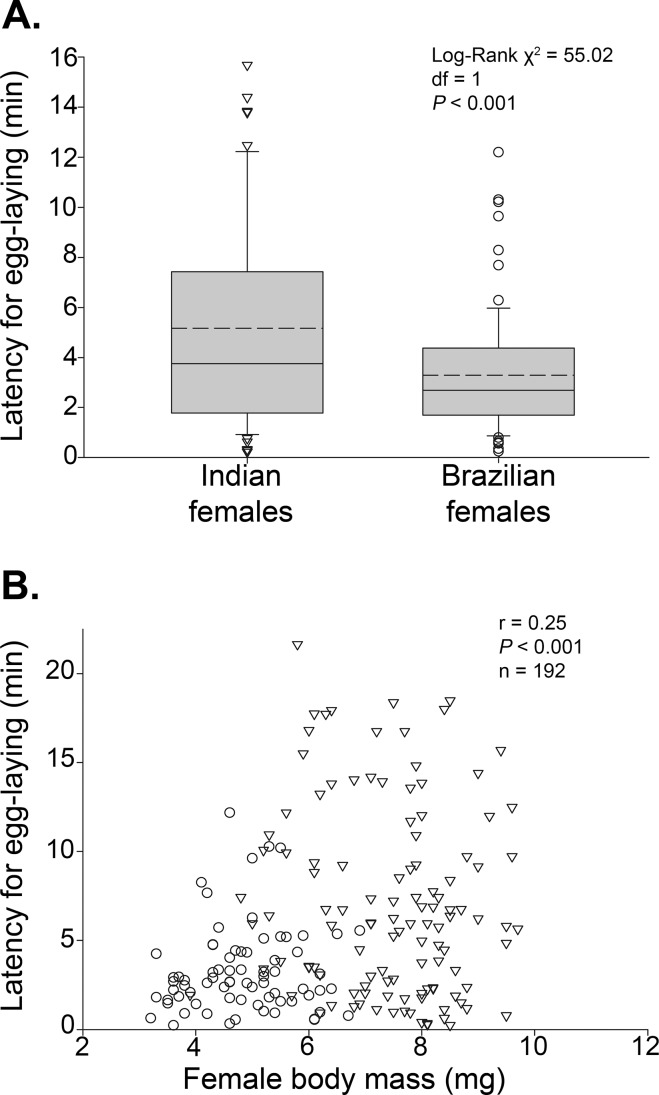
Latency to lay eggs on seeds in adult female cowpea beetles Callosobruchus maculatus during dichotomous choice trials.(A) A comparison of egg-laying latencies between Indian and Brazilian strain females showing that Indian females take longer to lay; the box plots indicate the median (solid line), mean (dashed line), and range of dispersion (lower and upper quartiles, and outliers) of the latency results. (B) Correlation between latency for egg laying and body mass of adult females from two strains (Indian as diamonds and Brazilian as circles).